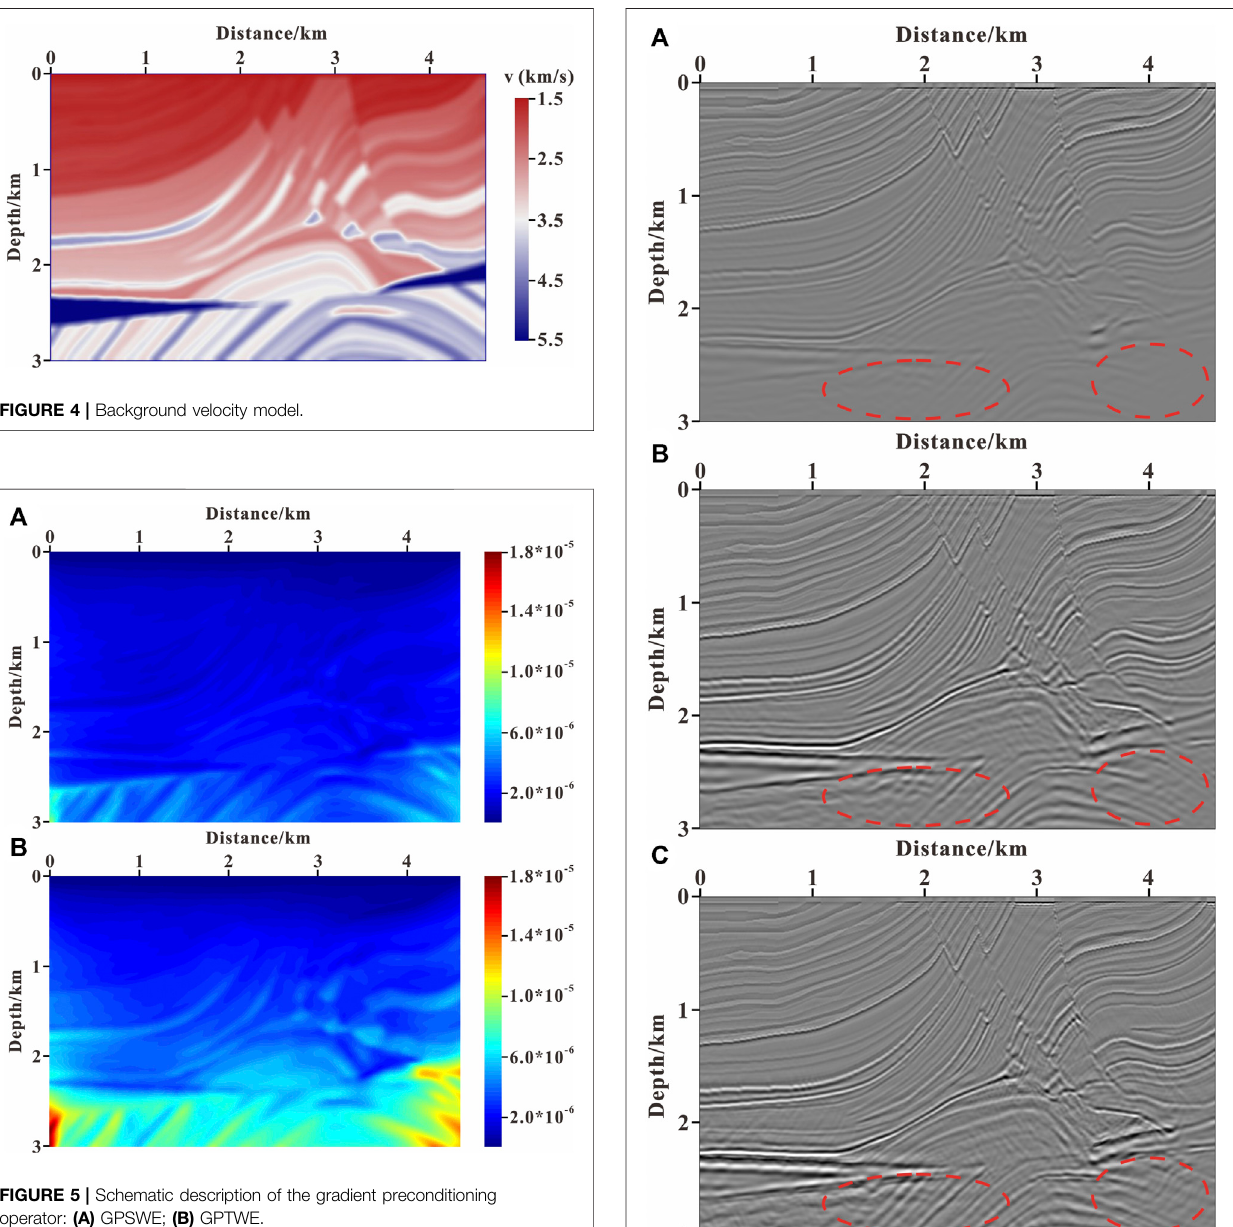
FIGURE 6 | Imaging results of LSRTM after 60 iterations: (A) without gradient preconditioning; (B) using GPSWE; and (C) using GPTWE.